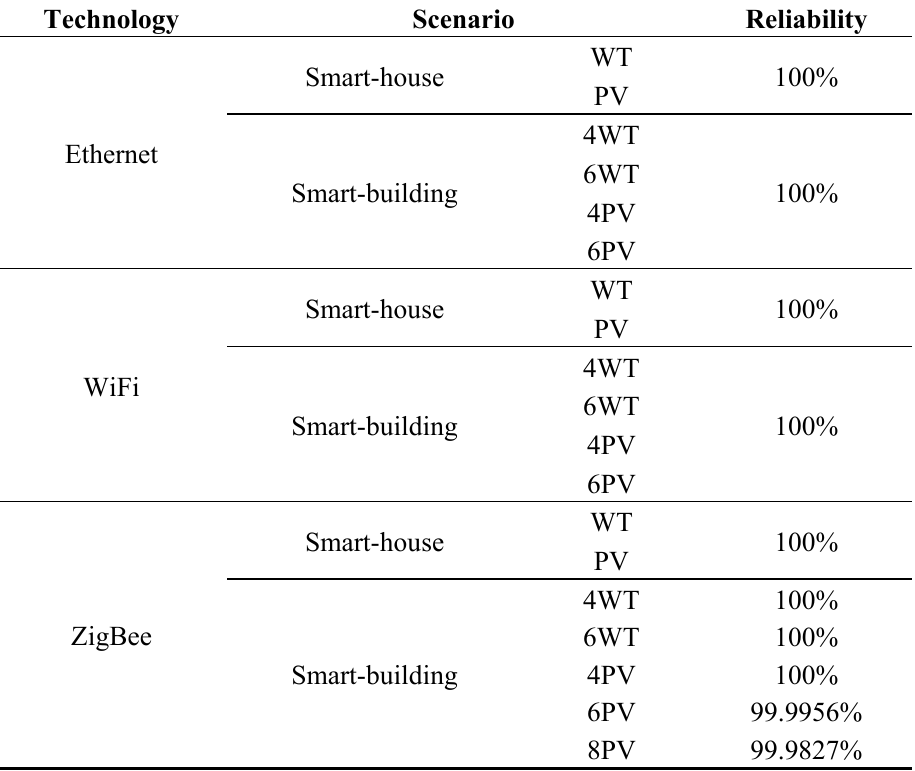
Table 11. Reliability results for smart-house and smart-building